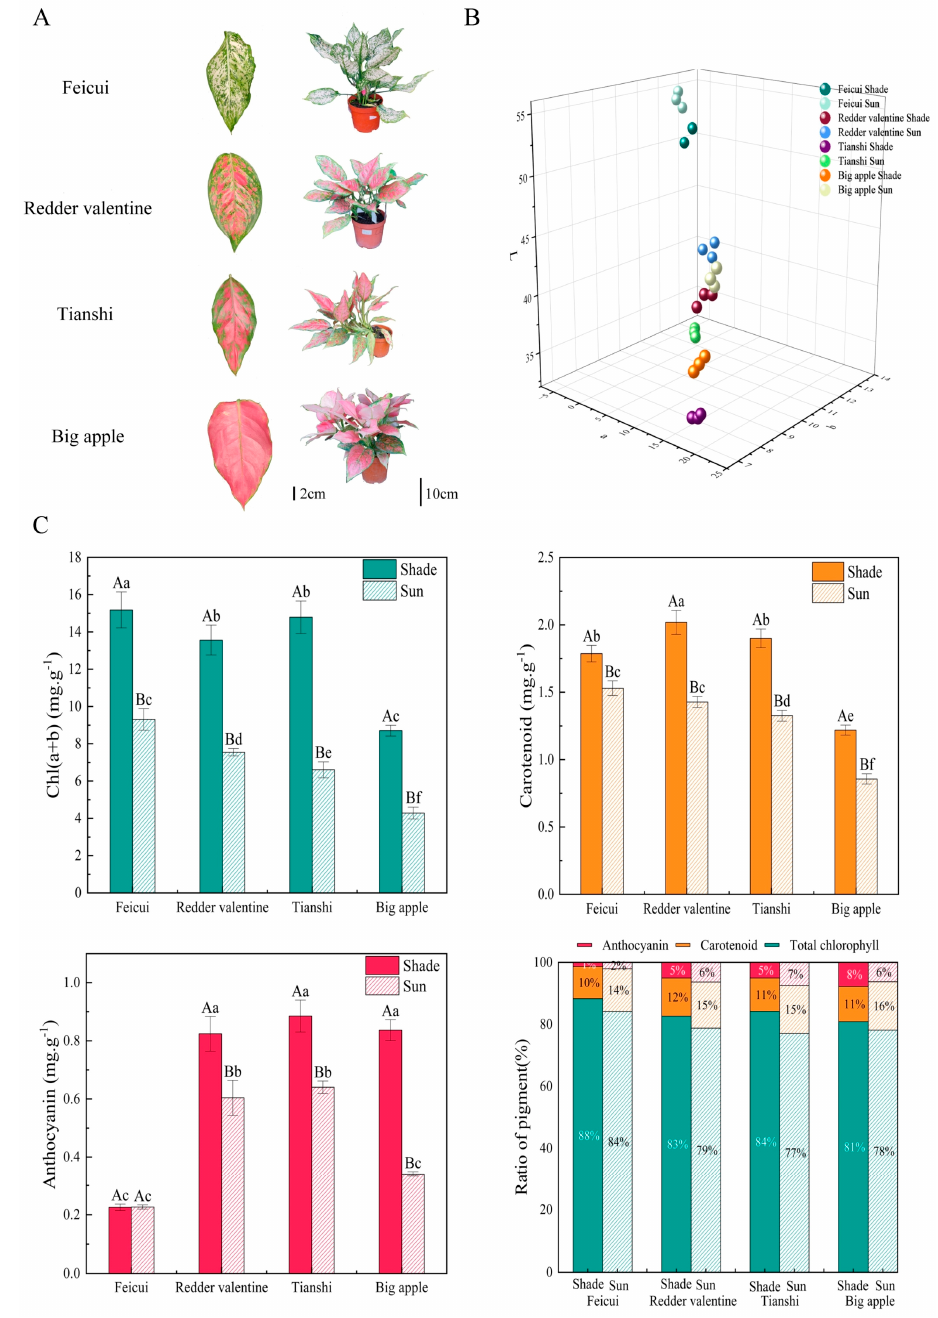
Figure 1. Colorimetric characterization and leaf pigment composition of four A. commutatum culti- vars: ( A ) Leaf phenotypes of 1.5-year-old seedlings under sun treatment. ( B ) Colorimetric analysis with an ‘L’ indicating lightness (+ brighter, − darker), ‘a’ indicating redness–greenness (+ redder, − greener), and ‘b’ indicating yellowness–blueness (+ yellower, − bluer). ( C ) Pigment (chlorophyll, Chl; carotenoid, Car and anthocyanin, ACN) contents and their percentage plot. Data represent the mean ± SD (n = 3). Different lowercase letters in the same column represent significant differences between cultivars, and different capital letters represent significant differences within the same cultivar ( p < 0.05, Duncan’s multiple range test).